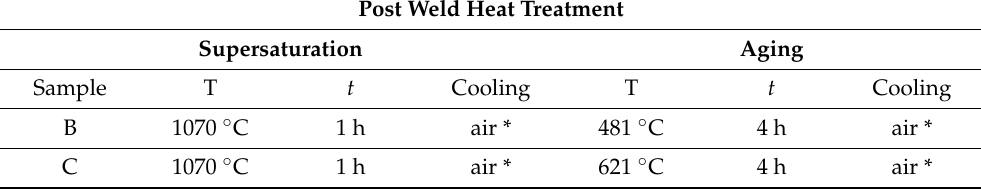
Table 3. The PWHT